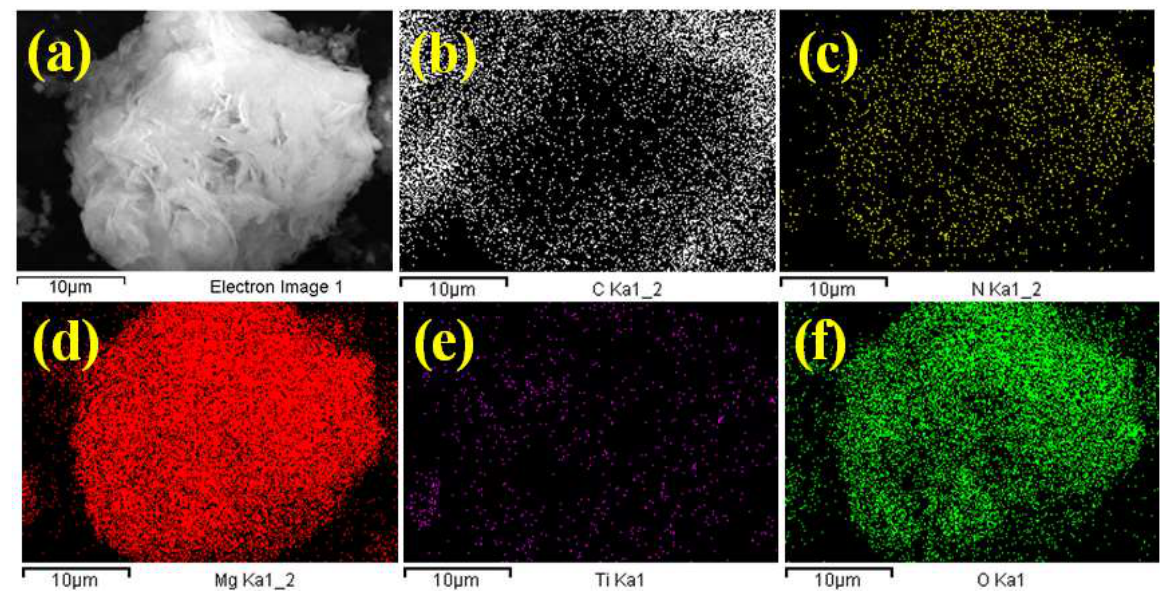
Figure 2. ( a ) EDS electronic image of MgTiO 3 @g-C 3 N 4 nanohybrid; elemental mapping of ( b ) carbon, ( c ) nitrogen, ( d ) magnesium, ( e ) titanium, and ( f ) oxygen in the synthesized MgTiO 3 @g-C 3 N 4 nano- hybrids.